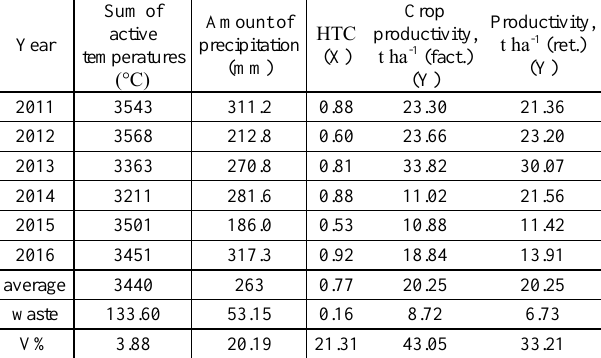
Table 1. Dependence of the lovage green mass productivity on the sum of active temperatures and precipitation during the vegetation periods in 2011-2016.